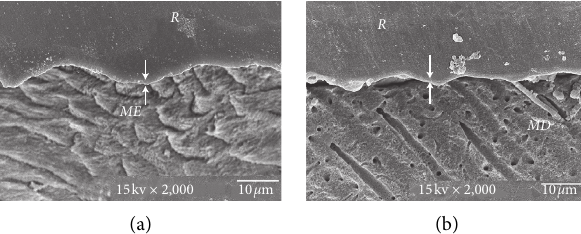
Figure 5: SEM micrograph of the AQ-Bond-restored resin composite after chemical challenge, demonstrating the consistent and con- tinuous thickness of the hybrid layer ( ≈ 1-2 μ m, arrowed) in the enamel (a) and dentin (b) (original × 2,000, ME � modified enamel, MD � modified dentin, and R � resin).